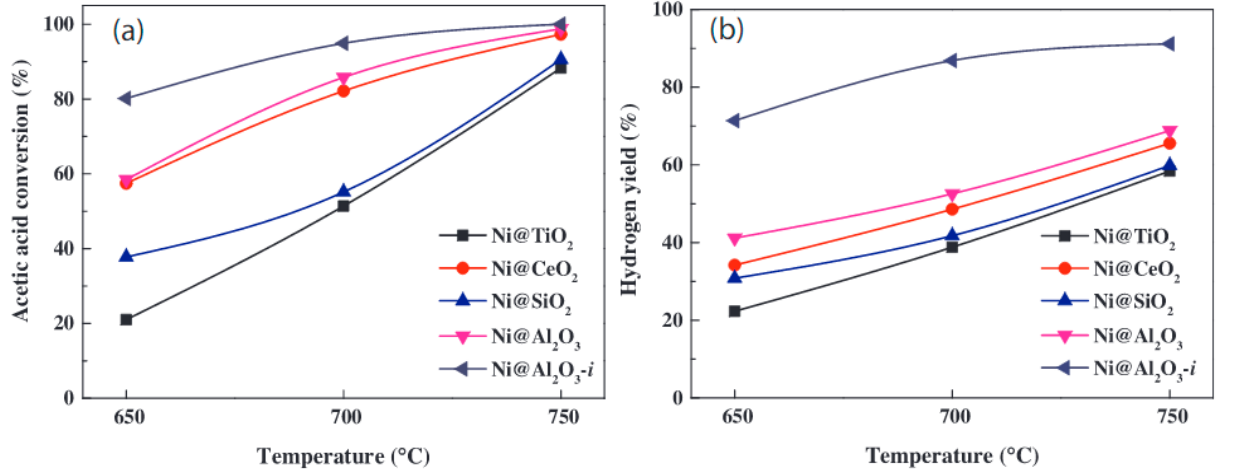
Figure 16. ( a ) Conversions of acetic acid and ( b ) H 2 yields in the steam reforming of acetic acid over different catalysts. Reaction conditions: 1 bar, WHSV = 21 h − 1 , and steam to carbon molar feed ratio = 3.18. Reprinted with permission from Ref. [201]. Copyright 2022 Elsevier.